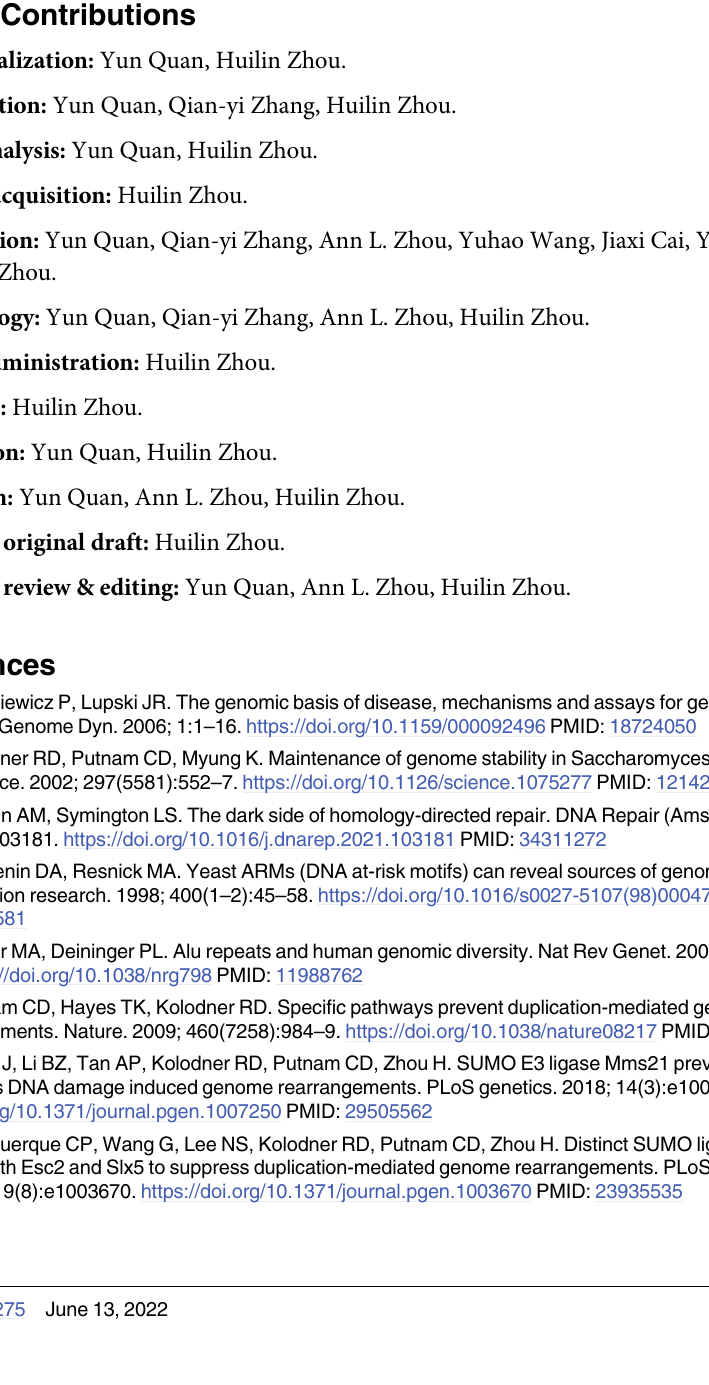
S3 Table. Plasmids